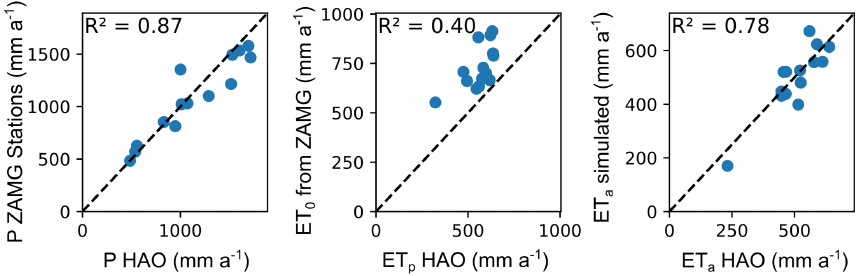
Figure A5. Scatterplots comparing the long-term averages of precipitation ( P ) and potential and actual evapotranspiration (ET p and ET a , respectively) from the digital Hydrological Atlas of Austria (HAO) (BMLFUW, 2007) with the corresponding rates from simulations in this study. The dashed diagonal black is the 1 : 1 line. Potential evapotranspiration in the HAO was calculated by Dobesch (2007) using the FAO approach described by Doorenbos and Pruitt (1977), resulting in lower values than those of this study which were calculated for a grass reference according to Allen et al.